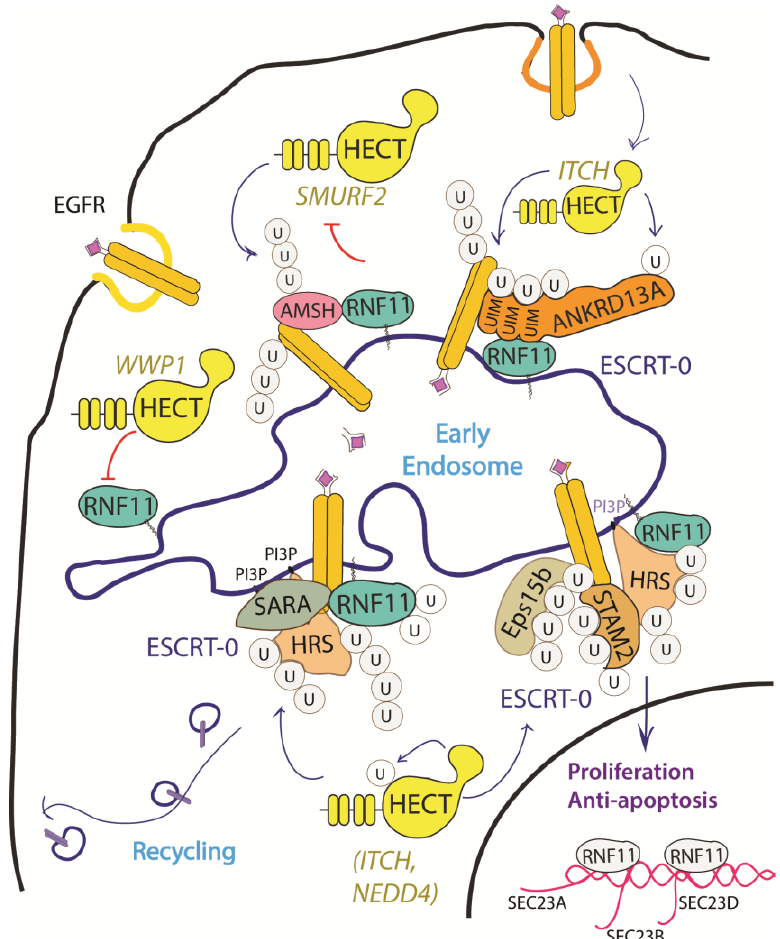
Figure 3. Graphical representation of the role of RNF11 in the EGFR signaling pathways. The Epidermal Growth Factor (EGF) receptor is a membrane tyrosine kinase that initiates cell growth and proliferation. Following ligand binding, the EGF receptor undergoes endocytosis via clathrin-dependent and clathrin-independent pathways. Following ligand stimulation, the EGF receptor undergoes endocytosis via clathrin-dependent and clathrin-independent pathways. Both routes require essential ESCRT-0 components, such as EPS15 and Epsin, which recognize the ubiquitin moieties conjugated on the receptor cytoplasmic tails following ligand stimulation. The ANKRD13 family of proteins could act as alternative ESCRT components that drive the receptor towards the endocytic routes.